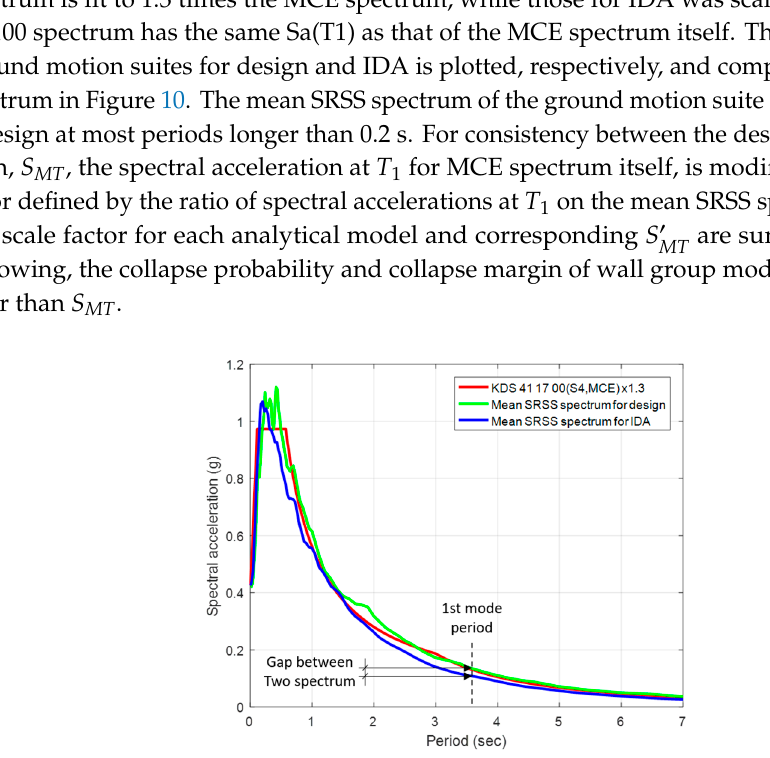
Figure 10. Mean SRSS Spectra of ground motion suites used for seismic design and performance evaluation. Table 8. Spectral accelerations at the fundamental period for MCE.